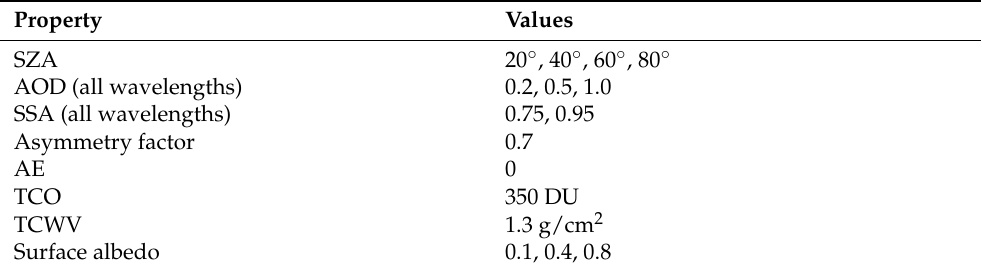
Figure 1. Three of the five artificial aerosol profiles that were used for the simulations (here for AOD = 1.5). Table 1. UVSPEC model input